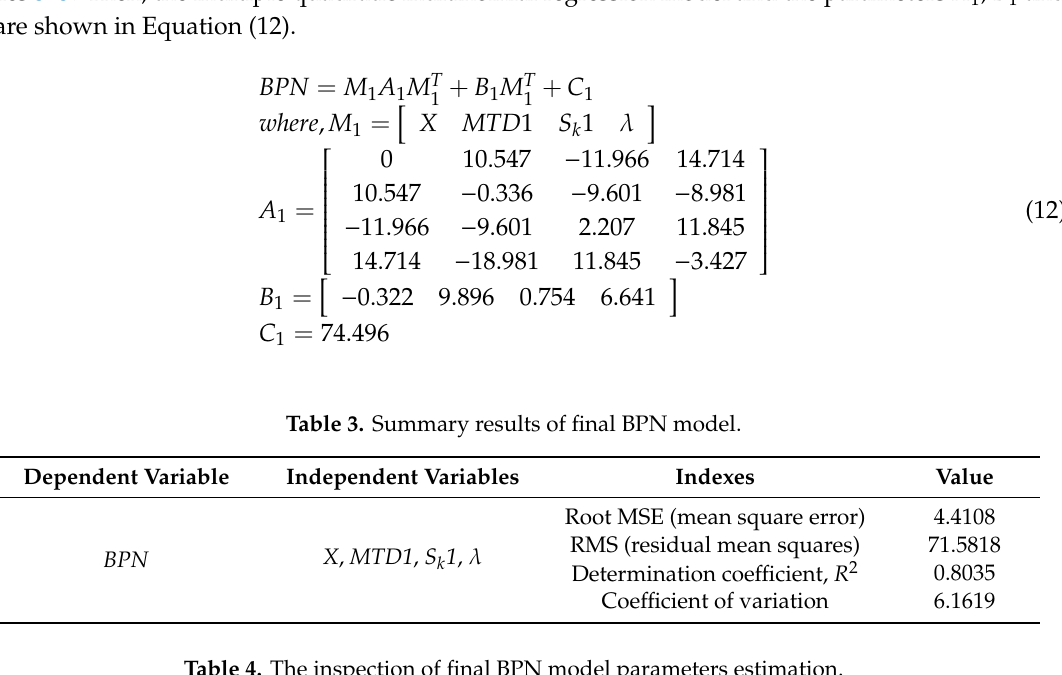
Table 4. The inspection of final BPN model parameters estimation.